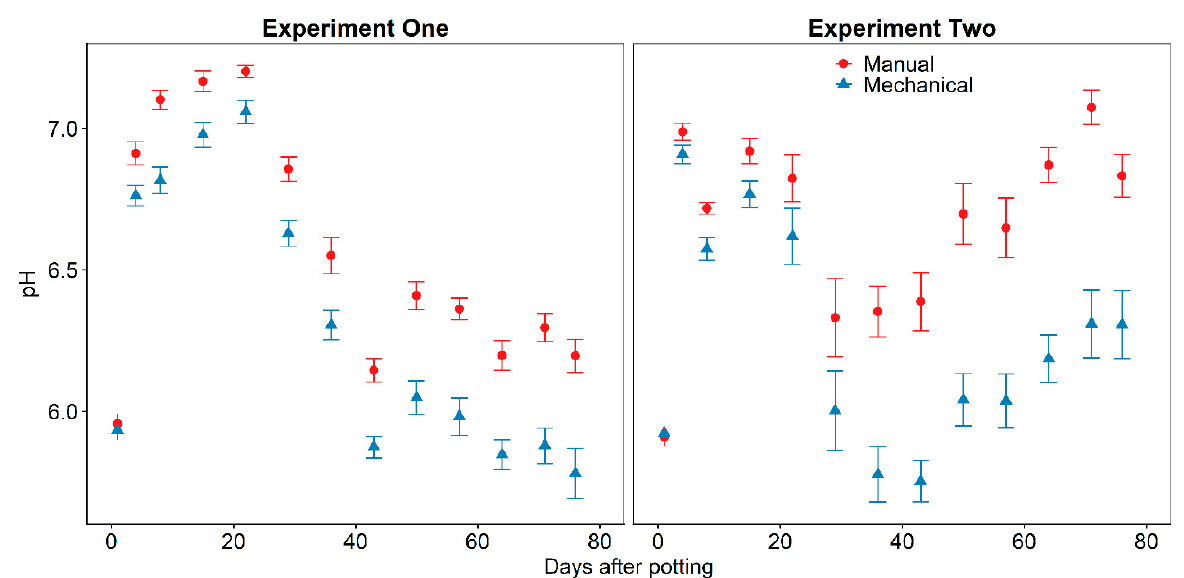
Figure 2. Mean leachate electrical conductivity from unplanted (Experiment One) or (Experiment Two) planted Douglas fir bark substrate with either manually or mechanically incorporated Osmocote Plus 15-9-12 controlled-release fertilizer. A significant difference ( p < 0.05) in mean leachate electrical conductivity was detected between the substrate with manually and mechanically incorporated controlled-release fertilizer for every single day during both experiments. Error bars are standard error ( n = 10) of the mean and points without error bars indicate the standard error is smaller than the size of the point.